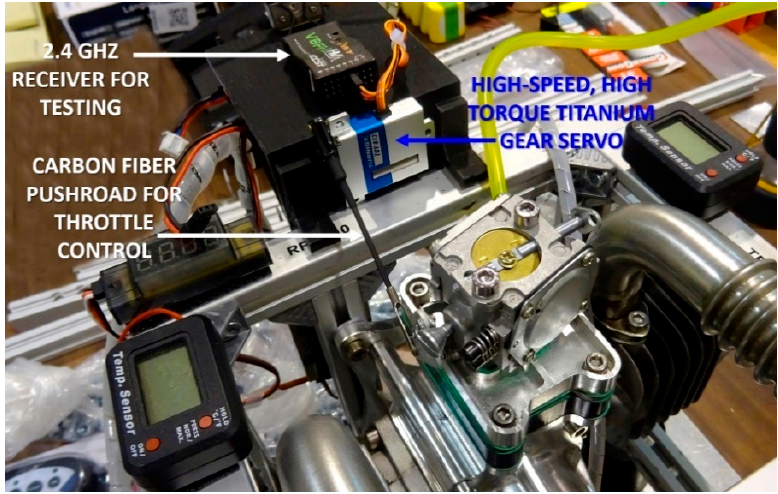
Figure 28. Throttle control .